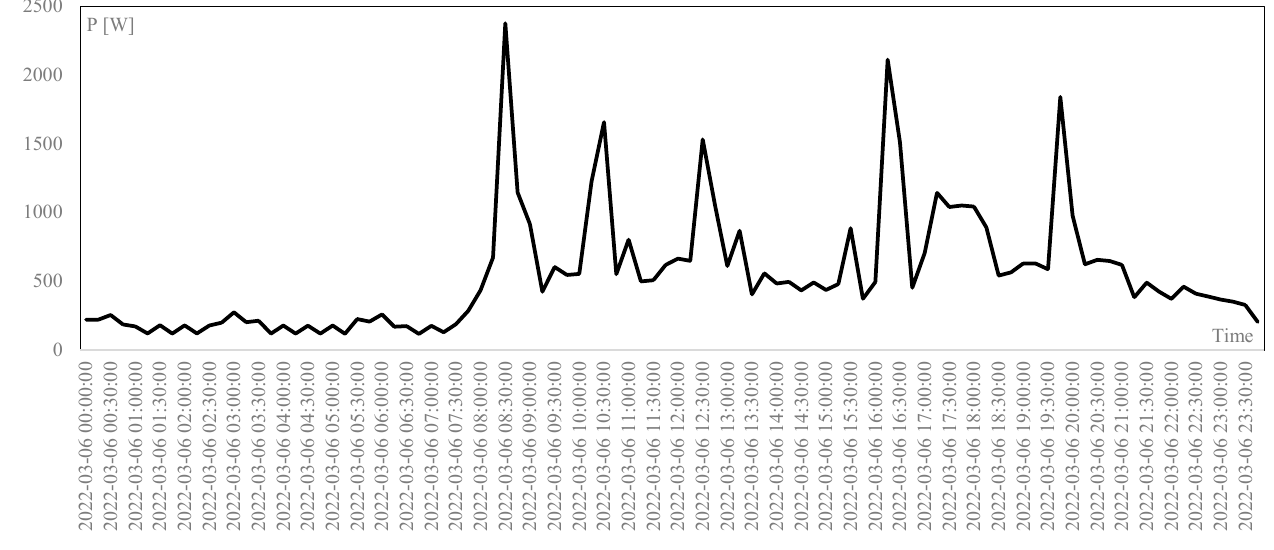
Figure 11. PV power production.